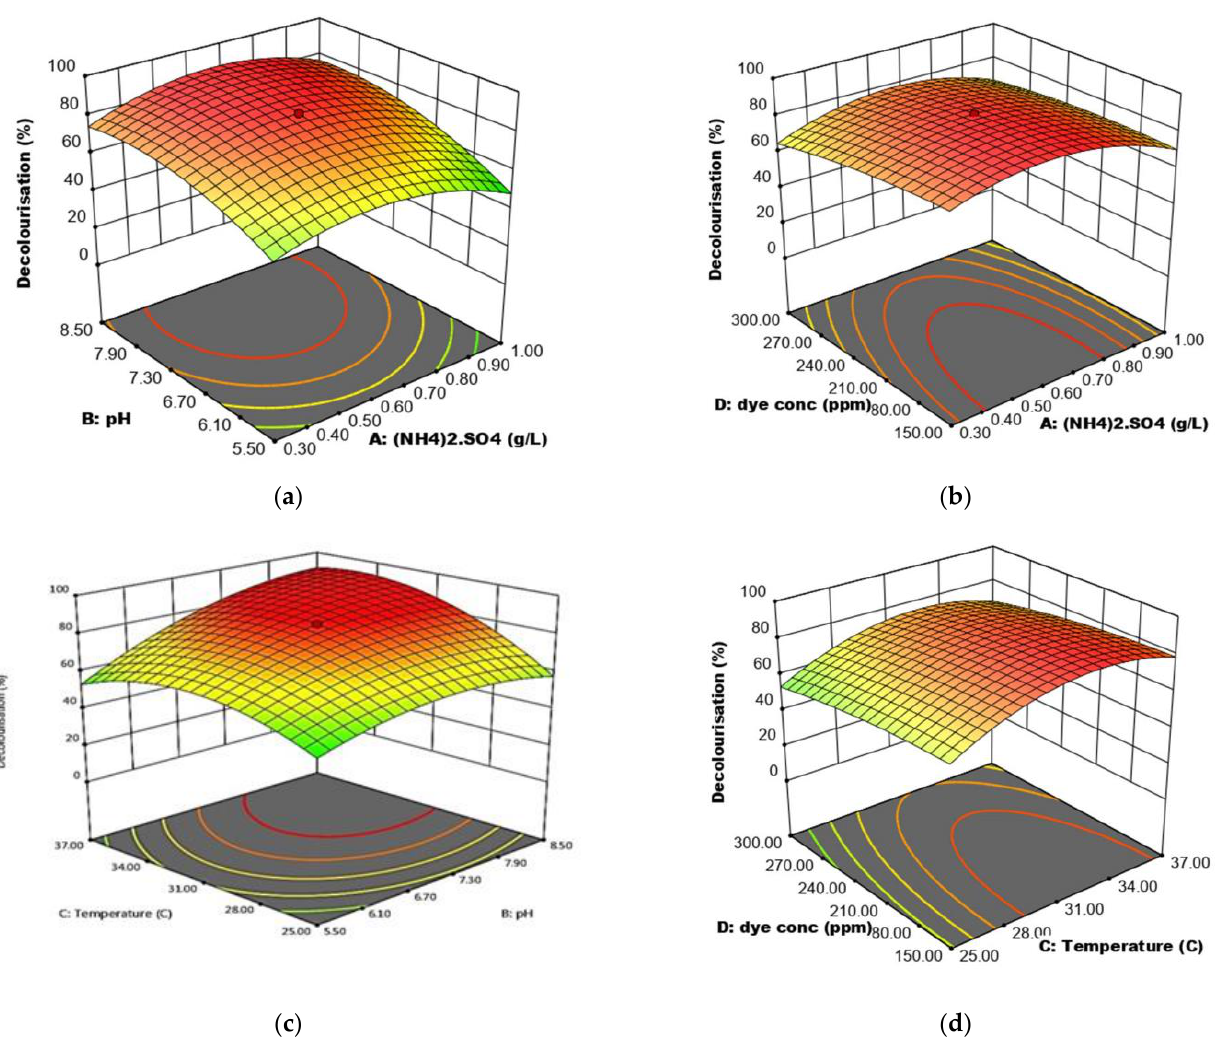
Figure 14. Response surface 3D contour showing ( a ) interaction between pH and ammonium sulphate concentration, ( b ) interaction between RR120 and ammonium sulphate concentration, ( c ) interaction between temperature and pH, ( d ) interaction between RR120 concentration and temperature.